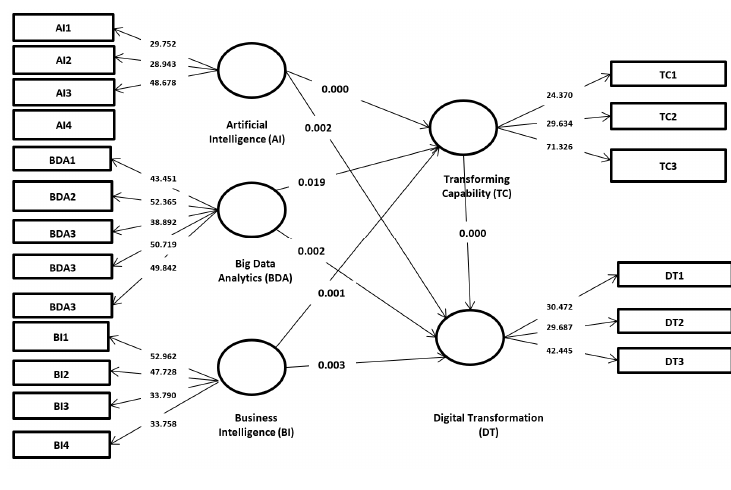
Fig. 2. Research Bootstrapping